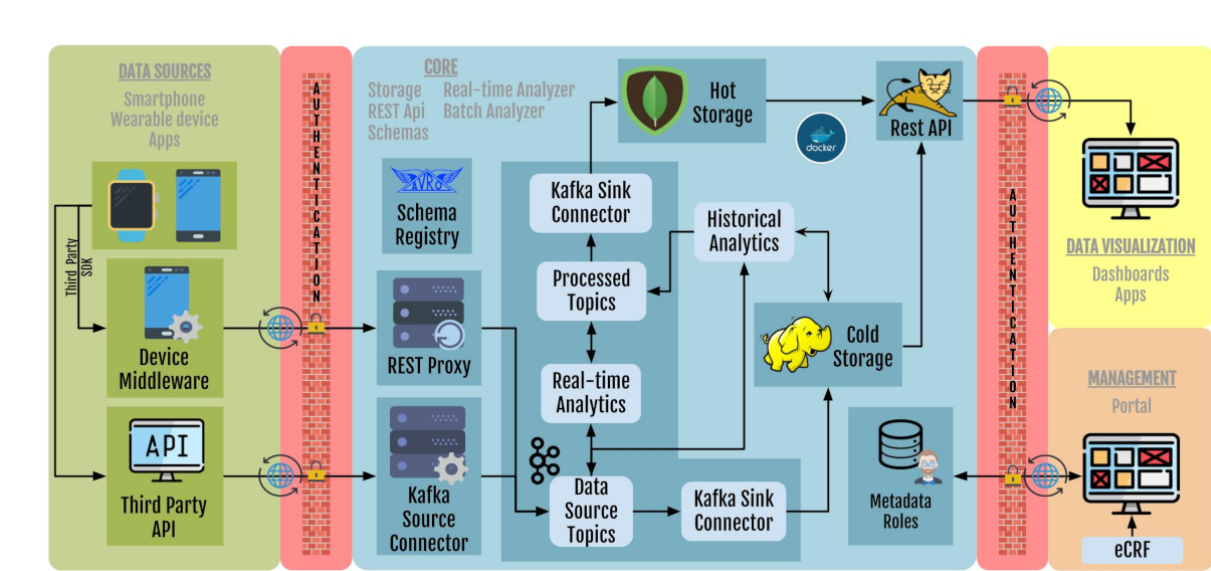
Figure 1. Technical overview of the RADAR-base platform